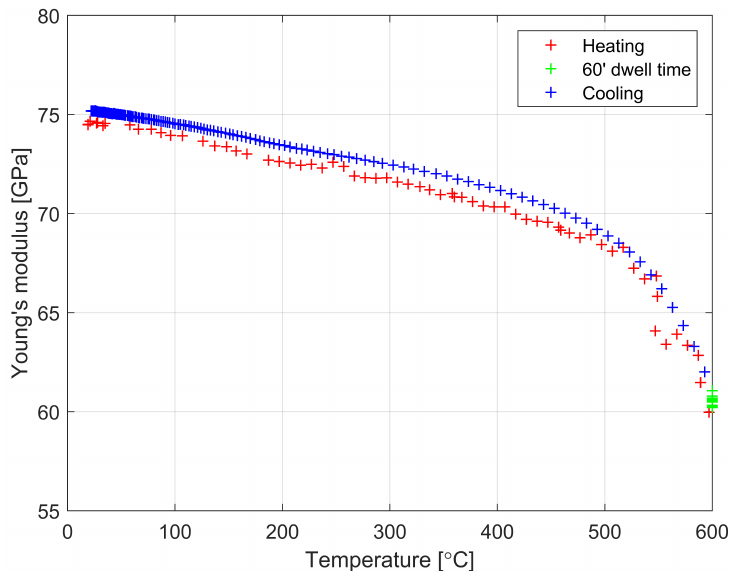
Figure 6. Dependencies of Young’s modulus versus temperature during the heating and cooling of soda lime glass with 60 min of dwell time at 873